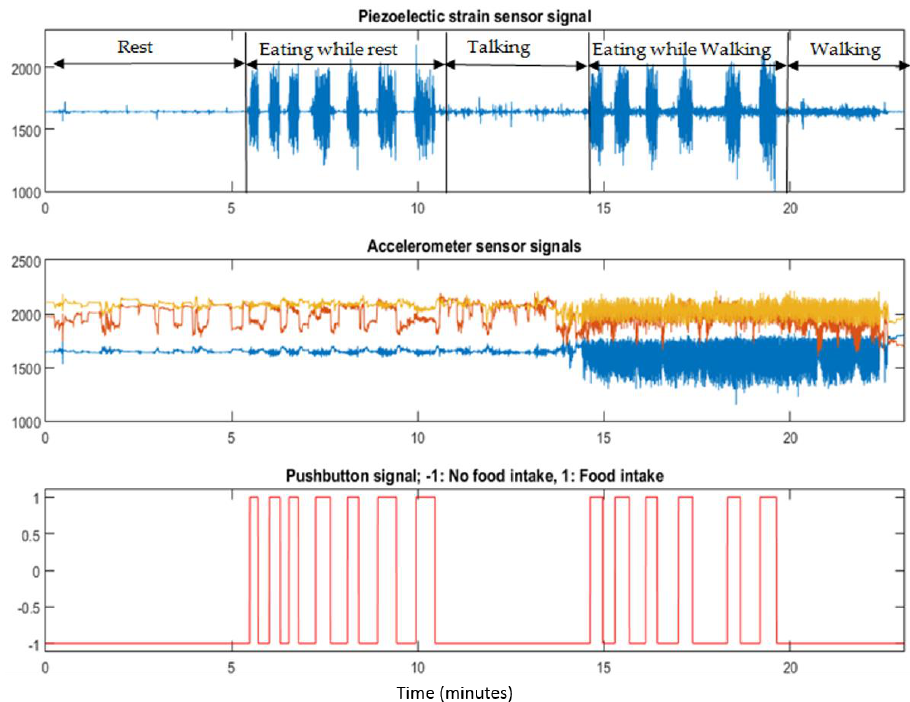
Figure 2. Sensor signals collected during the experiment. Piezoelectric sensor signals (first row) and accelerometer signals (second row) are used to differentiate between eating and physical activities. Eating episodes were marked by participants using a pushbutton (third row).